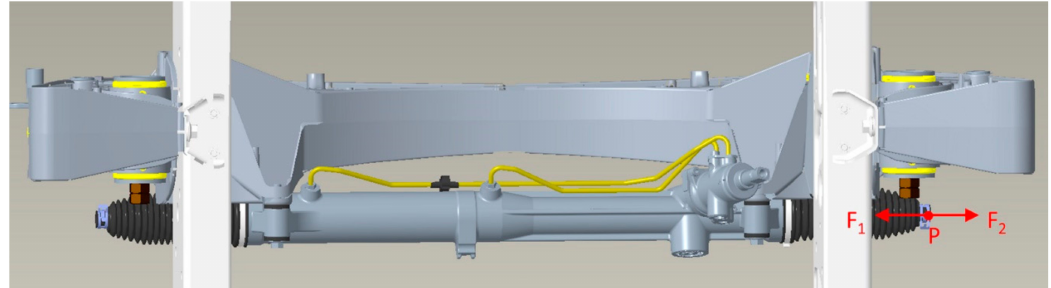
Figure 7. Configurations for the fatigue testing of cross beam resistance under hydraulic steering system